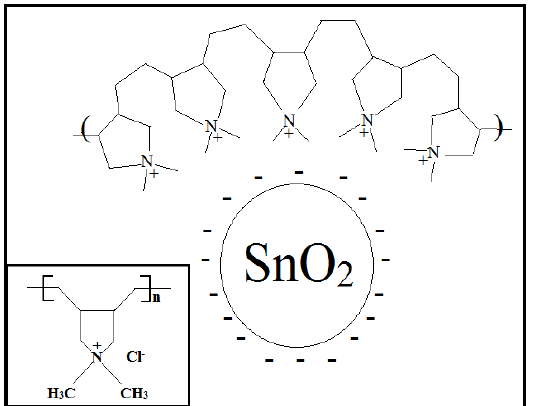
Figure 9. The electrostatic interaction between SnO chemical structure of